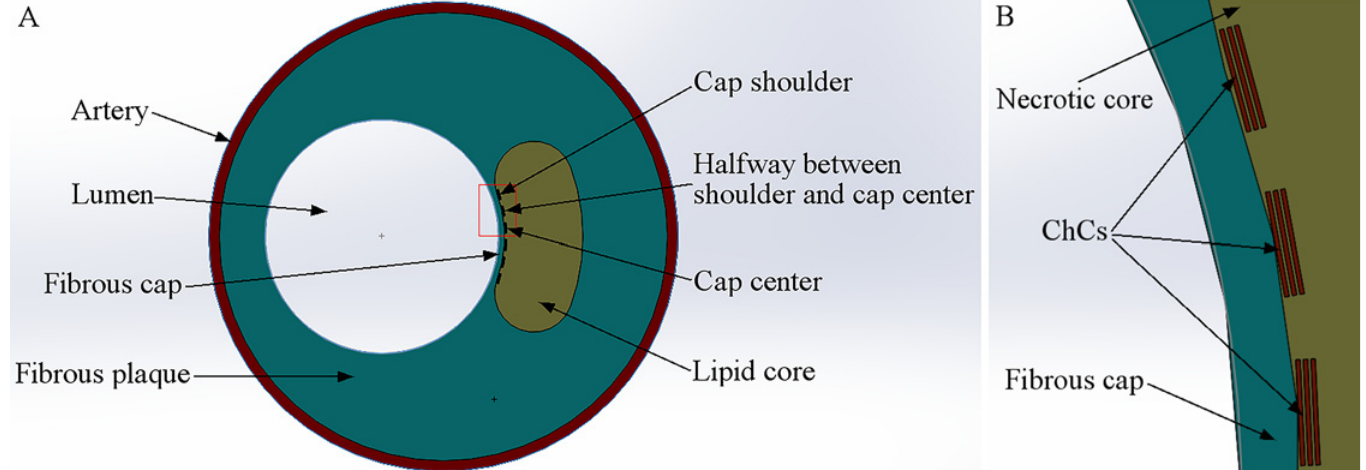
Fig 1. Diagram of an Idealized Cross-section of an Atherosclerotic Coronary Artery. A: Structure of the overall atherosclerotic coronary artery. B: Magnified view of the thin fibrous cap with the cholesterol crystals illustrated in the red box in A.